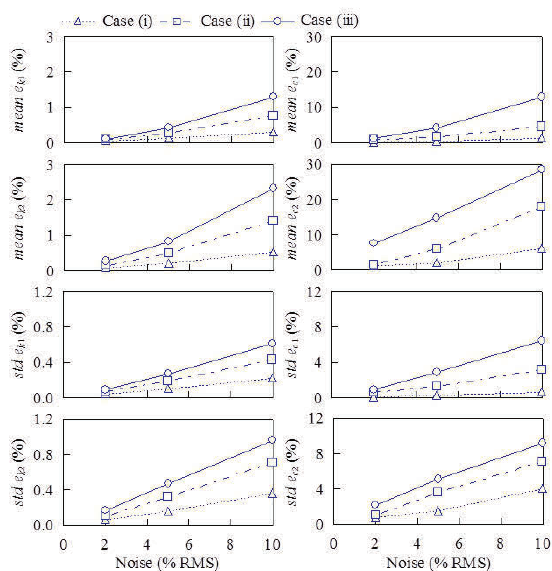
Figure 7. Means and std’s of normalized estimation er- ror using substructural identification approach: Case (i): f s;acc D f s;disp D 200 Hz; Case (ii): f s;acc D 200